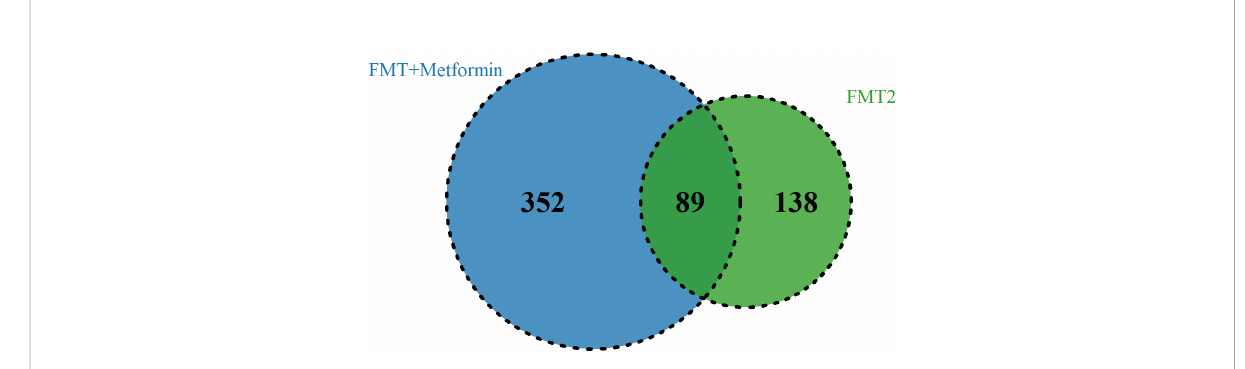
FIGURE 6 The commonly and signi fi cantly different species of between the FMT alone and FMT plus metformin